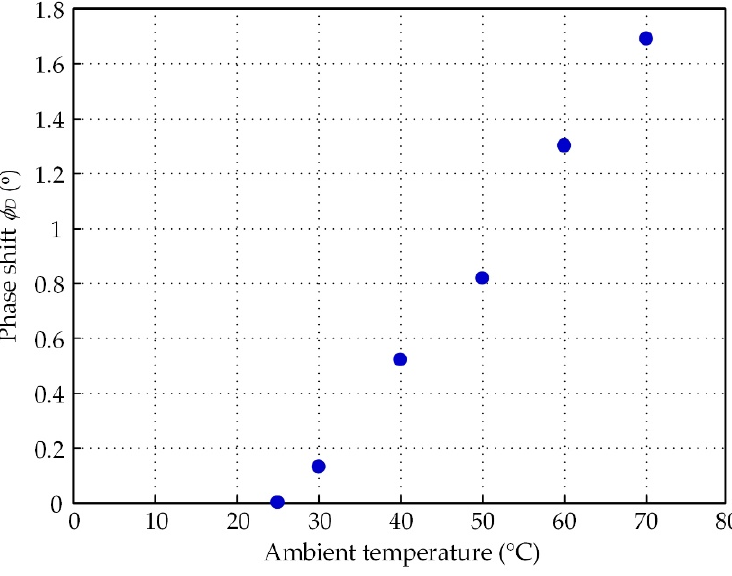
Figure 7. Measured result of phase shift φ D .